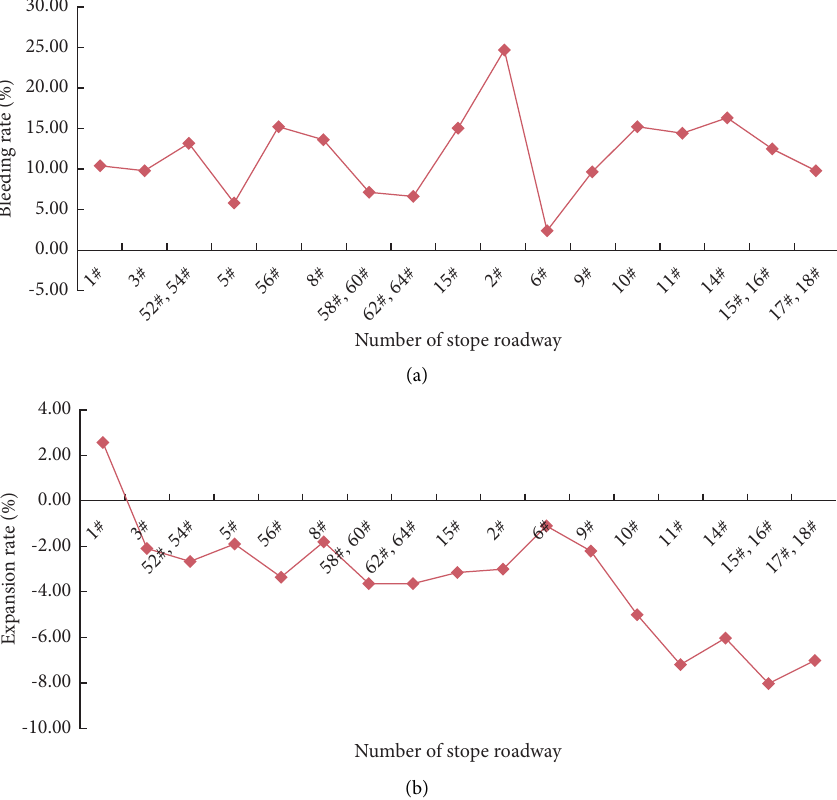
Figure 4: Experimental monitoring curve of (a) slurry bleeding rate and (b) expansion